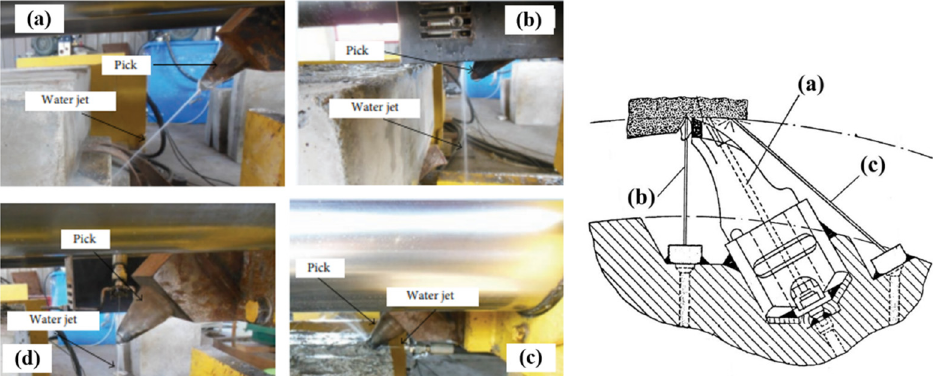
Figure 1. View and scheme of configurations of the high-pressure jet in relation to the cutting pick edge: ( a ) inside, in the pick axis, ( b ) in front of the pick edge, ( c ) behind the pick edge, ( d ) on the side of the pick edge [14].